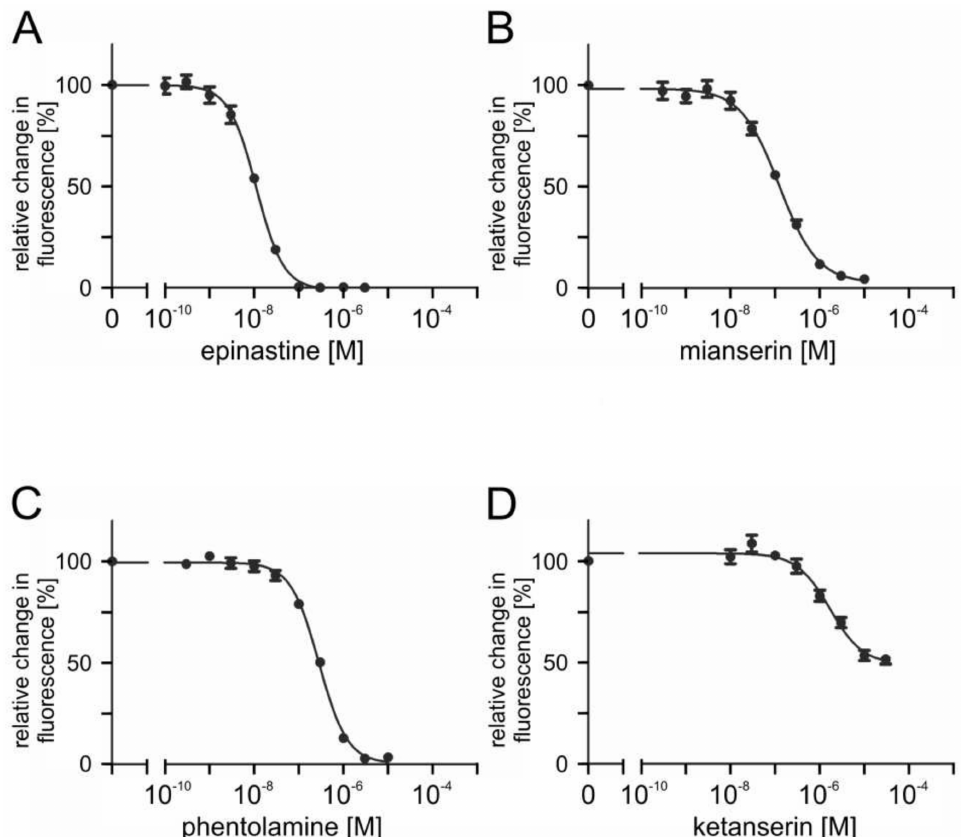
Figure 8. Effects of putative antagonists on tyramine-activated PaOct β 2R-HA. Concentration series of ( A ) epinastine, ( B ) mianserin, ( C ) phentolamine, and ( D ) ketanserin were applied in the presence of 1 × 10 7 M tyramine and 1 × 10 − 4 M IBMX. Relative change in fluorescence (corresponding to the amount of cAMP) is given as the percentage of the value obtained in the exclusive presence of 1 × 10 − 7 M tyramine (=100%). Data represent the mean ± SD of eight values from a typical experiment. All determinations were independently repeated at least three times. Table 3. Mean values for half-maximal inhibition (IC 50 [M] and pIC 50 ± SD) for substances with antagonistic activity on tyramine activated PaOct β 2R. For each substance, at least three independent experiments (n) with octuplicate measurements were performed. Values were obtained from non- linear fitting of the data from concentration-response curves (GraphPad Prism 5.04). The maximal inhibition of PaOct β 2R-HA activity is given in [%]. Maximal Substance IC 50 [M] pIC 50 n Inhibition [%] epinastine 1.3 × 10 − 8